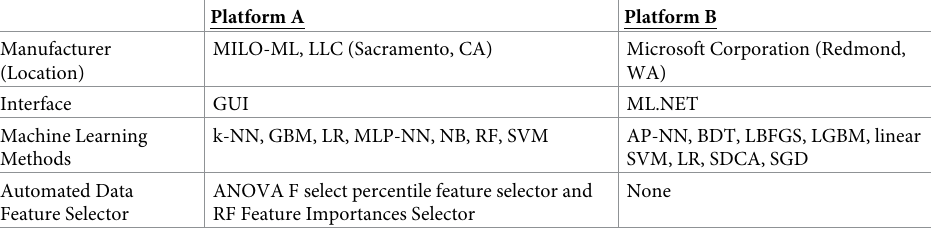
Table 1. Comparison of AutoML